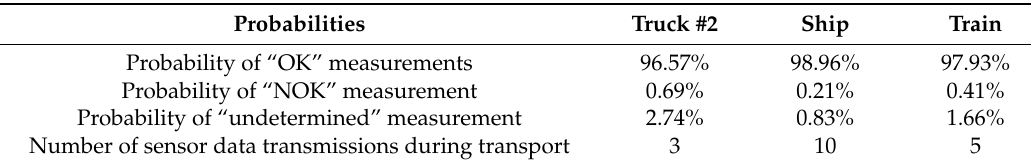
Table 5. Sensor measurement probabilities of the transport relations in scenarios 3 and